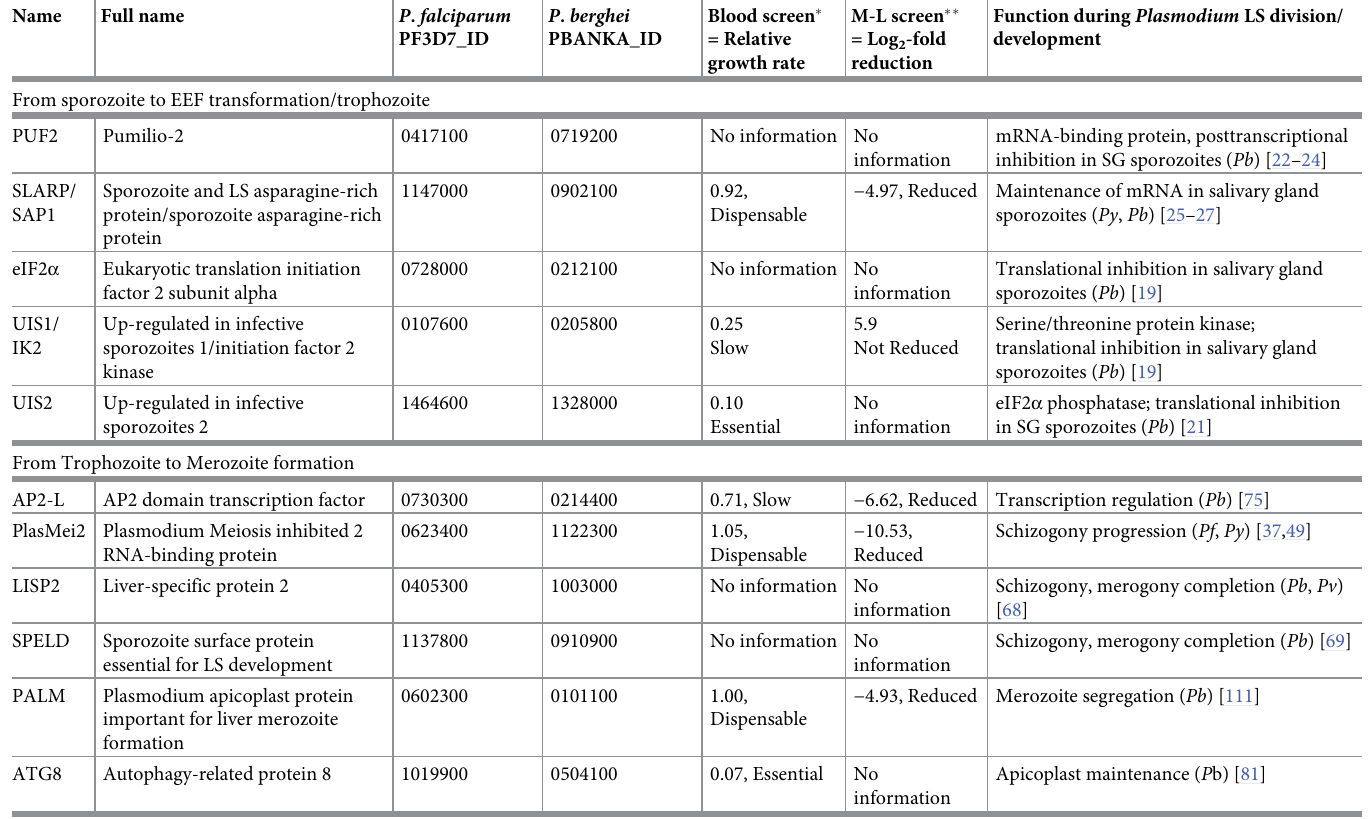
Table 1. List of proteins involved in Plasmodium LS cell division and development mentioned within this